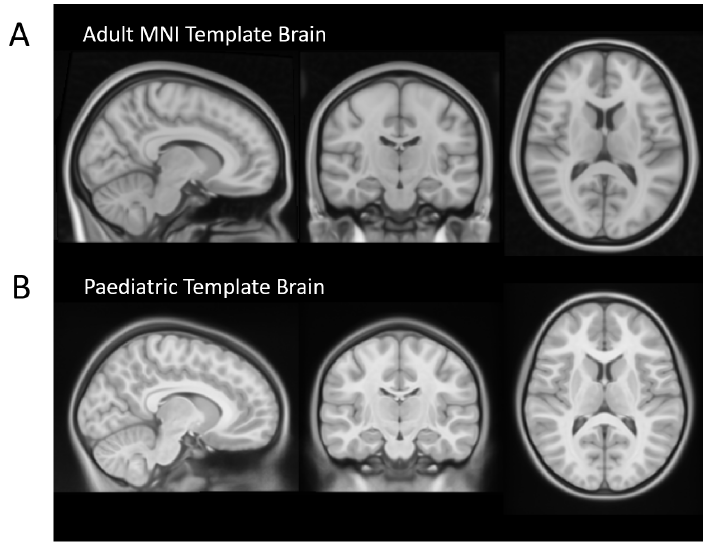
Figure 4. Adult MNI compared with the NIH Paediatric Template Brain. ( A ) Adult 1mm MNI Template Brain which is commonly used as the standard space image for functional MRI analysis (available as part of FS L ). ( B ) A symmetric paediatric template brain that has been created by Fonov et al. , 2011 59 , using structural images from 112 children, aged 7 – 11 years. Use of an age-appropriate template is important in paediatric studies due to important differences between the brains of adults and children. For example, children have less developed frontal lobes, thinner corpus callosum and smaller